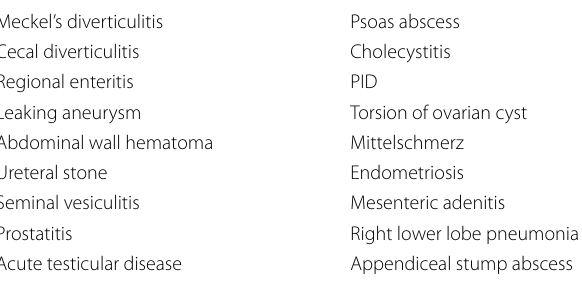
Table 1 Differential diagnosis of right lower quadrant pain after appendectomy Meckel’s diverticulitis